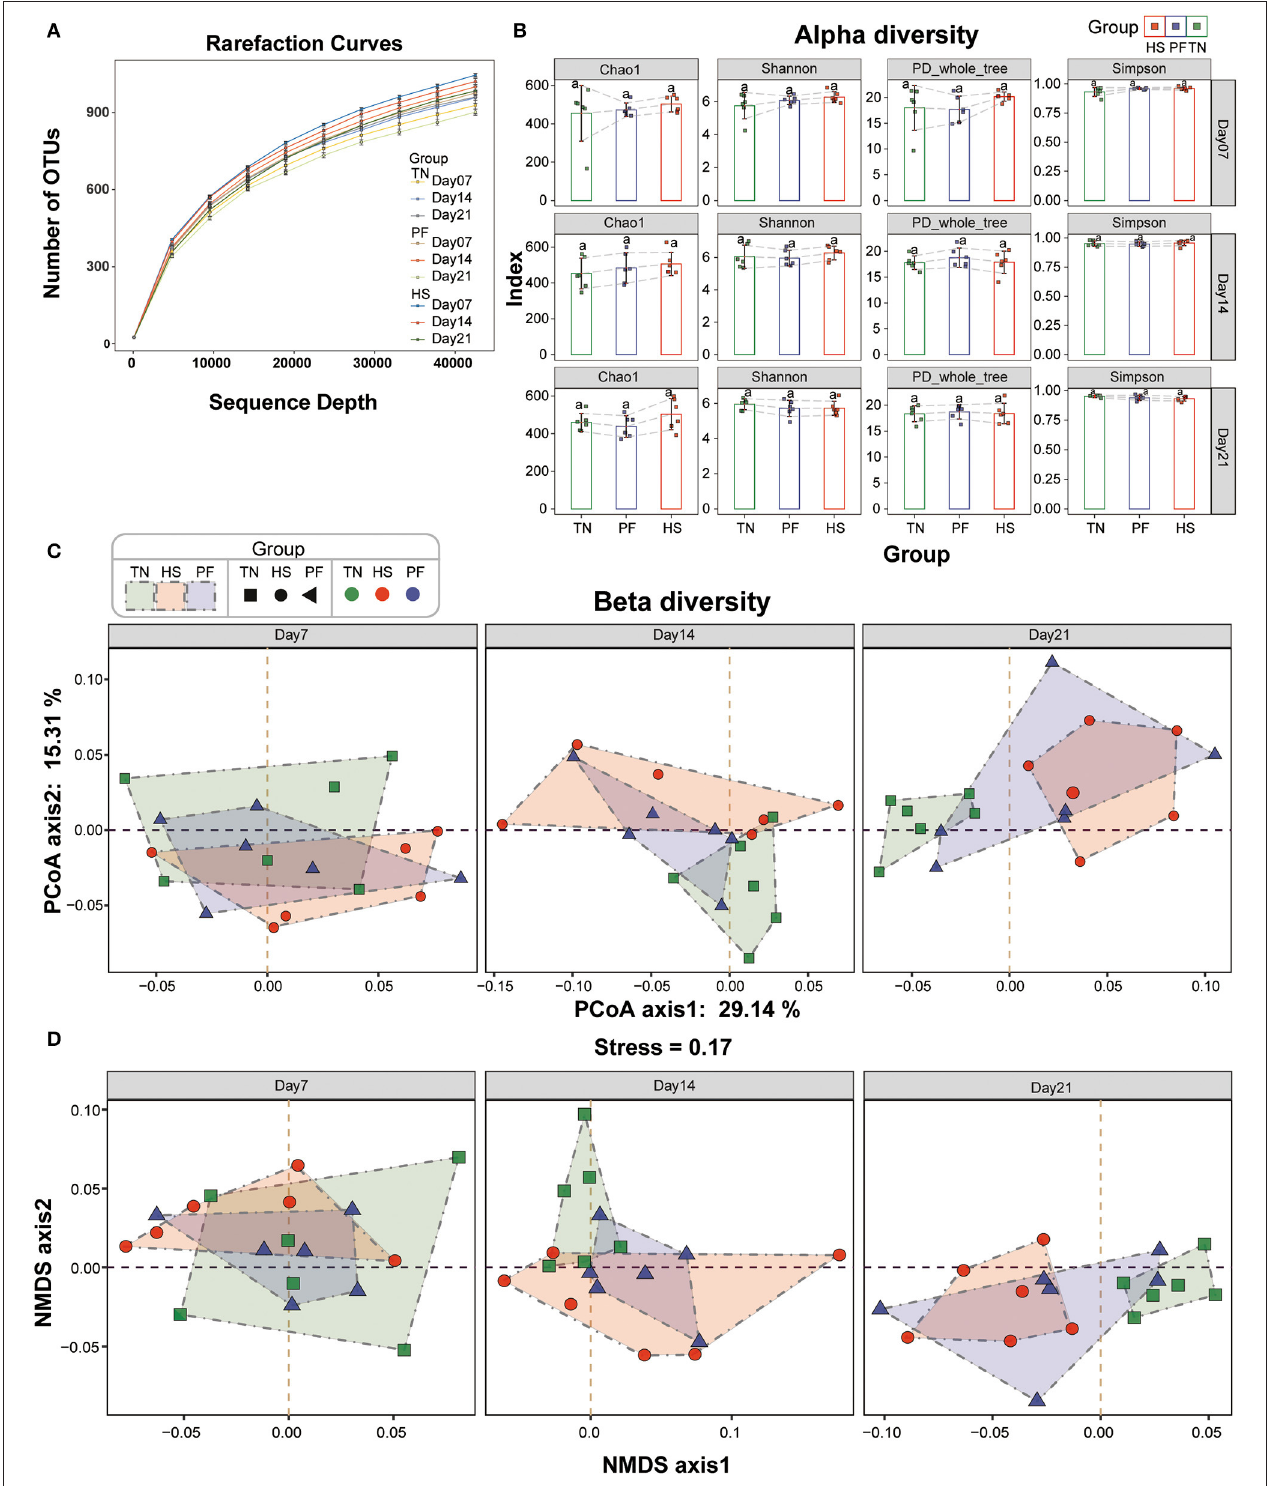
FIGURE 2 | Comparisons of alpha diversity and beta diversity indices in cecal microbial communities of hens among different experimental groups. (A) Rarefaction curves of cecal bacteria from the three groups at each time point. (B) The α -diversity was compared among the TN, HS, and PF groups using Chao1, Shannon, PD_whole_tree, and Simpson diversity indices. Means with the same letter do not differ statistically; means with different letters are statistically different ( p < 0.05). (C) A principal coordinate analysis (PCoA) plot of beta diversity based on the unweighted Unifrac distance matrices. (D) A non-metric multidimensional scaling (NMDS) plot of beta diversity based on the unweighted Unifrac distance